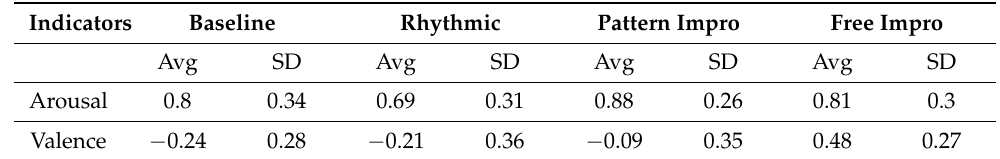
Table 3. Average and standard deviation values for arousal and valence for baseline and the rhythmic exercise, pattern improvisation and free improvisation tasks.